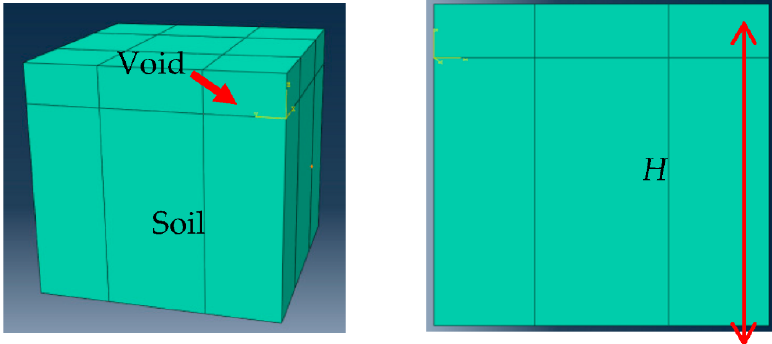
Figure 6. Overview of the numerical model of the track plate and the soil.